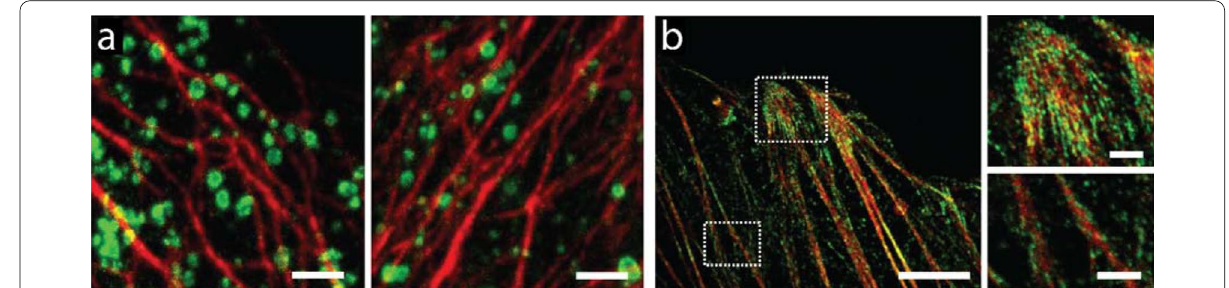
Fig. 3 Protein-retention ExM (proExM) of HeLa cells using acryloyl-X, SE (AcX) as the protein anchor. a Dual-color proExM of clathrin (fused to mEmerald, green) and keratin (mRuby2, red). Two representative images are shown. Scale bar, 1 μm (4.3 μm; here and after, physical size after the expansion, if available, is shown in brackets). b Dual-color proExM image of actin (mRuby2, red) and paxillin (mEmerald, green) fusions. Insets are magnified views of the boxed regions. Scale bars, 5 μm (21.5 μm) and 1 μm (4.3 μm, insets). (Reprinted/adapted by permission from Spring Nature: Tillberg et al. [37], copyright